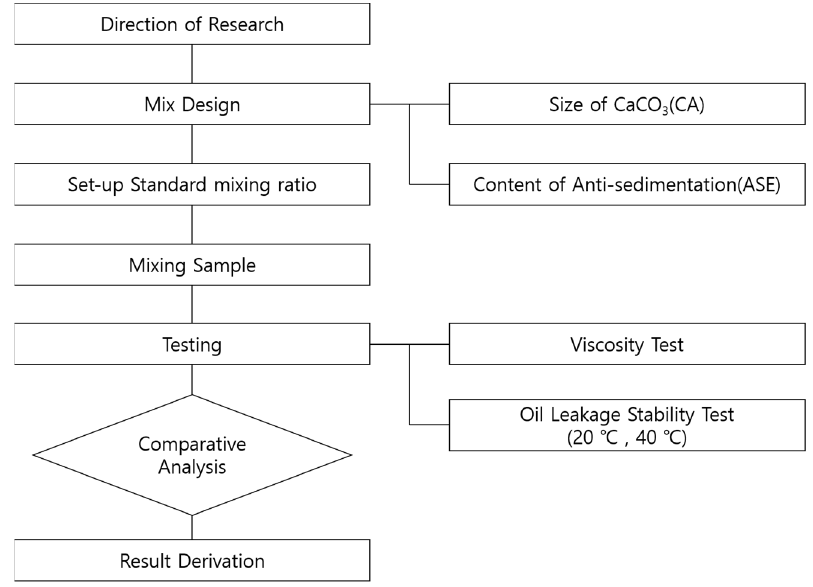
Figure 5. Research flow chart.